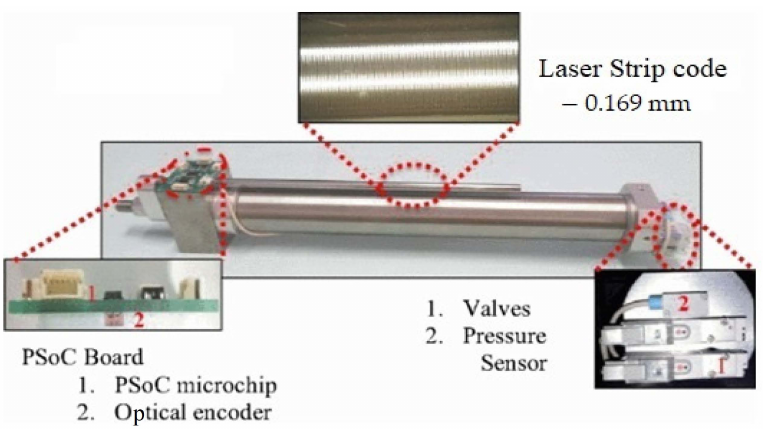
Figure 1. The experimental setup for the system.